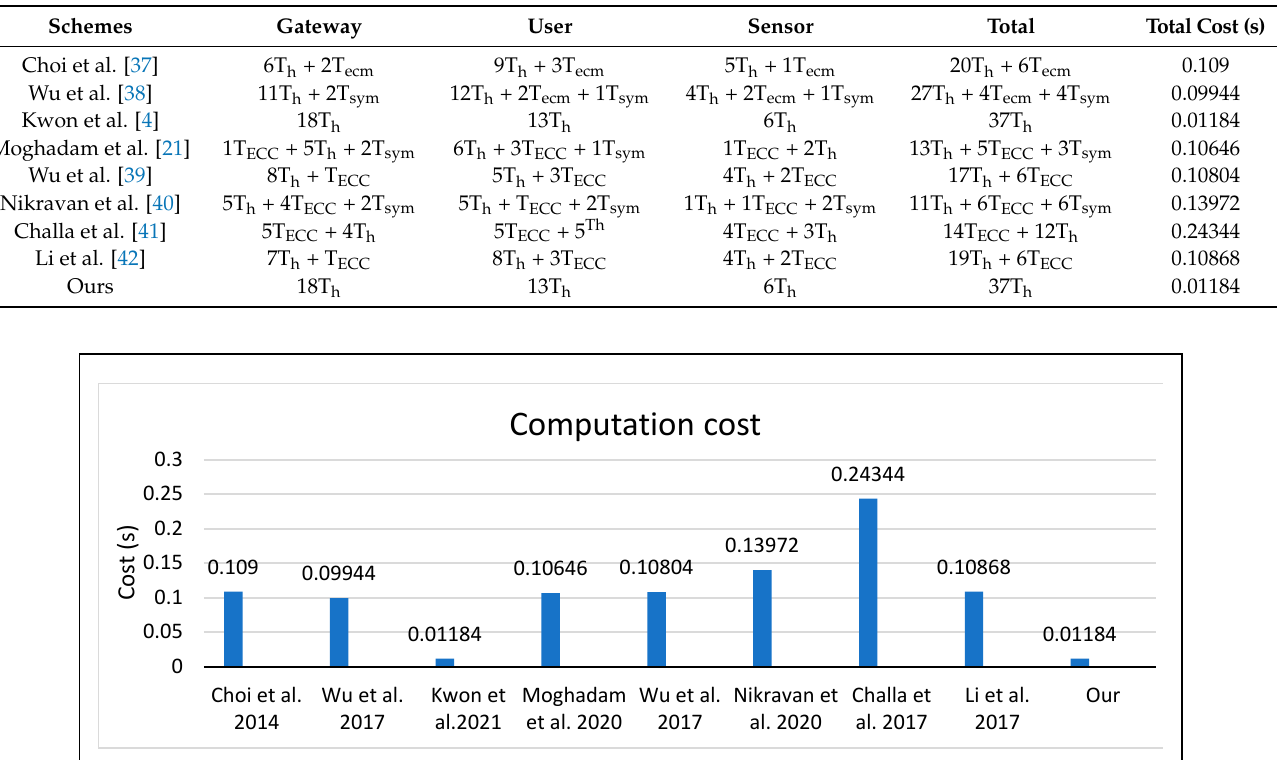
Table 12. Security properties.